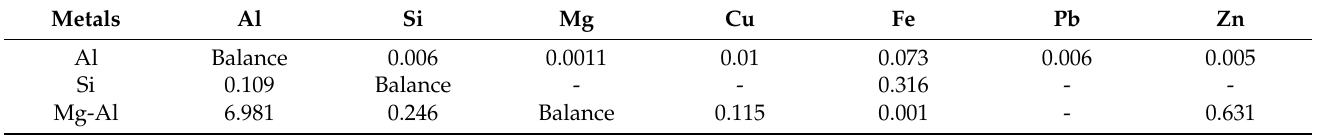
Table 1. Chemical compositions (wt.%) of metals used to prepare the studied Al-Si-Mg